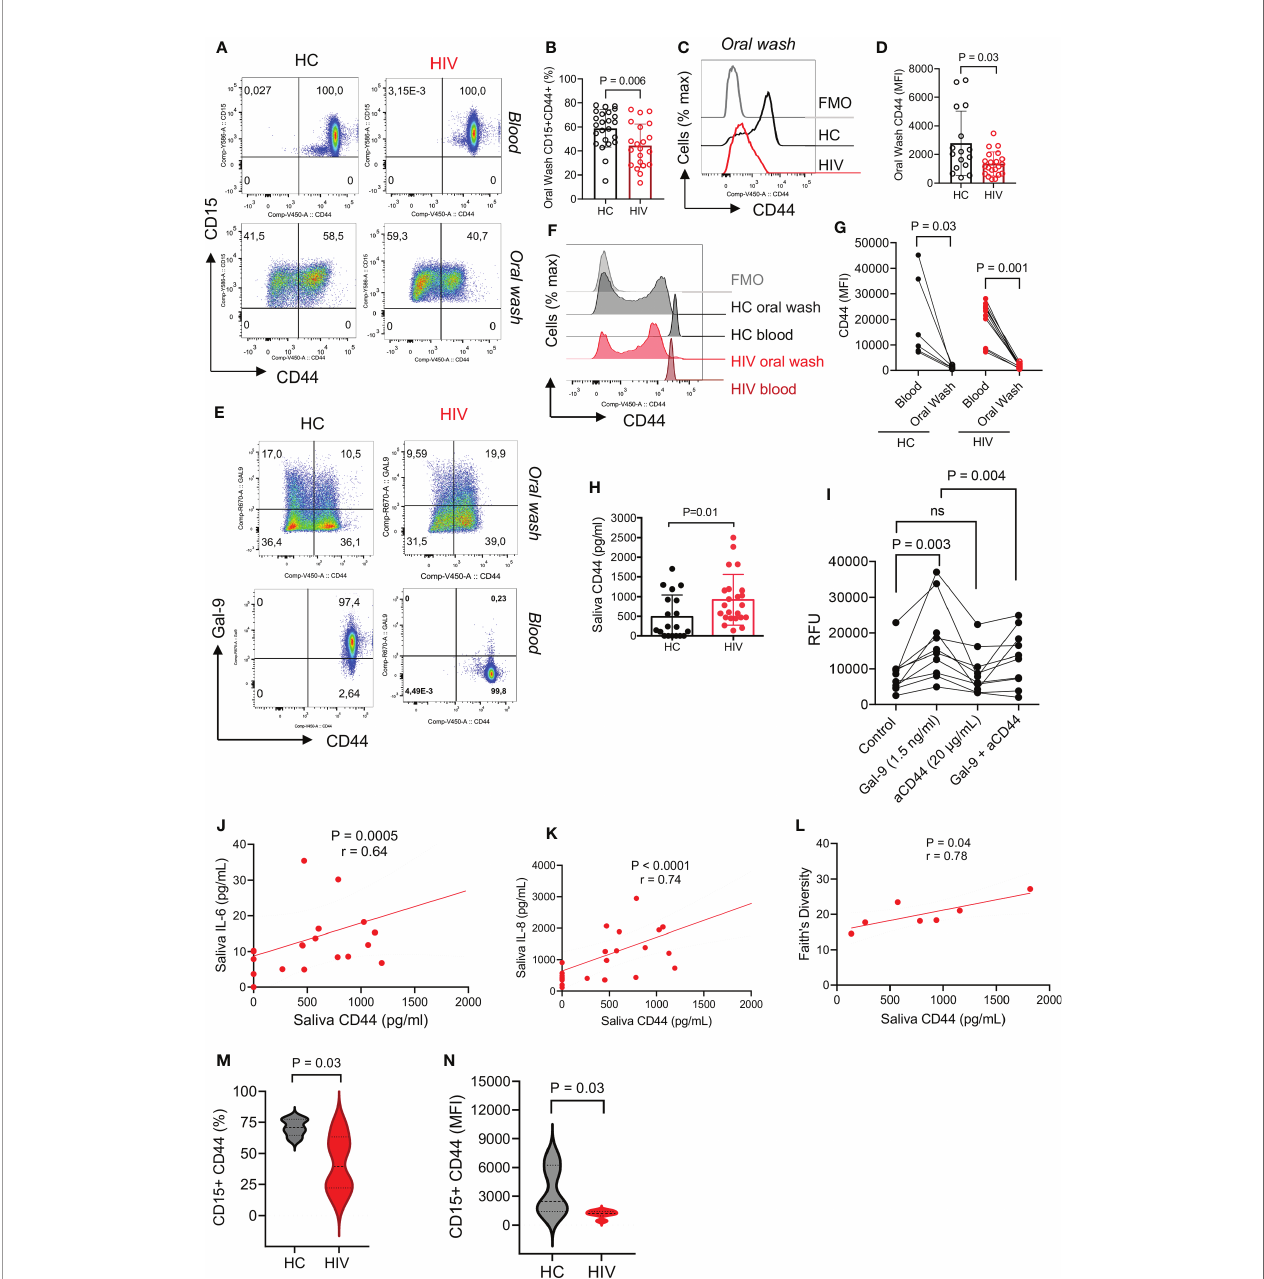
FIGURE 3 | CD44 is downregulated from the surface of oral neutrophils in HIV-infected individuals. (A) Representative fl ow cytometry plots of CD45 expression on blood and oral neutrophils. (B) Cumulative data of CD45 expression on oral neutrophils of HIV-infected versus healthy individuals. (C) Representative histogram plots, and (D) cumulative data of CD44 expression (MFI) in oral neutrophils of HV-infected individuals vs. HCs. (E) Representative fl ow cytometry plots of co-expression of CD44 and Gal-9 in oral and blood neutrophils in HIV-infected vs. healthy individuals. (F) Representative histogram plots, and (G) cumulative data of CD44 expression (MFI) in the blood and oral neutrophils of HIV-infected vs. healthy individuals. (H) Concentrations of soluble CD44 in the saliva of HIV-infected vs. healthy individuals as measured by ELISA. (I) Cumulative data showing blood neutrophil migration in the presence of soluble Gal-9 (1.5 ng/ml), anti-CD44 antibody (20 m g/ml), or soluble Gal-9 (1.5 ng/ml) plus anti- CD44 antibody while all wells were treated with fMLP (50 m m). (J) Cumulative results showing a positive correlation between the soluble CD44 with IL-6 in the saliva of HIV- infected individuals, calculated by Spearman correlation (K) Cumulative results showing a positive correlation between the soluble CD44 with IL-8 in the saliva of HIV- infected individuals, calculated by Spearman correlation. (L) Cumulative data showing a positive correlation between the soluble CD44 with bacterial Faith ’ s diversity, measured by Spearman correlation. (M) Cumulative data of percentages of neutrophils expression CD44 in the oral cavity of HCs versus HIV-infected individuals that were subjected to 16S gene sequencing. (N) Cumulative data of the intensity of CD44 expression on neutrophils from the oral cavity of HCs versus HIV-infected individuals that were subjected to 16S gene sequencing. ns, no signi fi